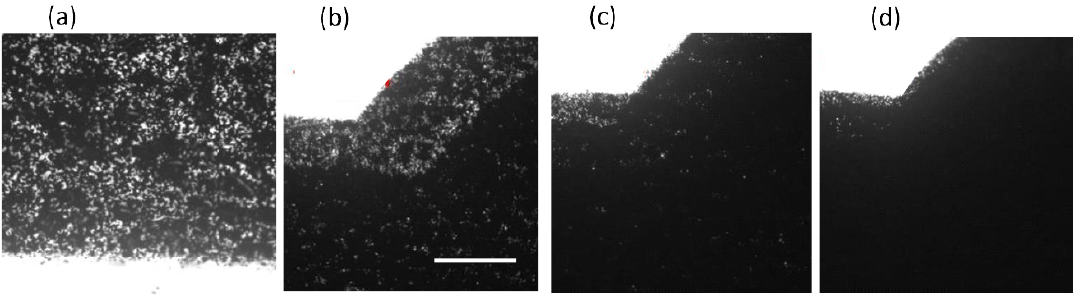
Figure 2. The toner coverage on the printed paper after printing ( a ) once, ( b ) twice, ( c ) three times,